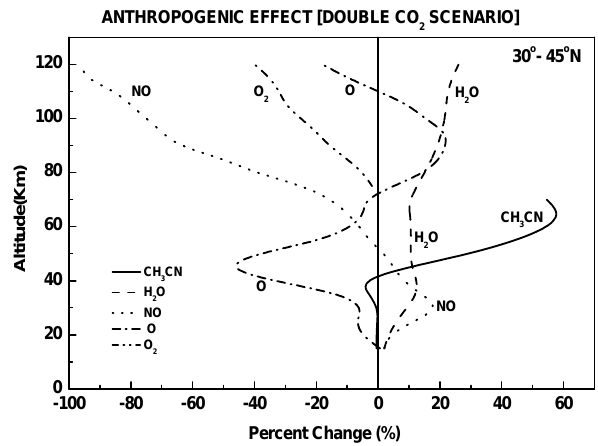
Fig. 1. Percentage change in the concentrations of various impor- tant neutral species for the double-CO 2 scenario for the middle at- mosphere for 30 ◦ –45 ◦ N